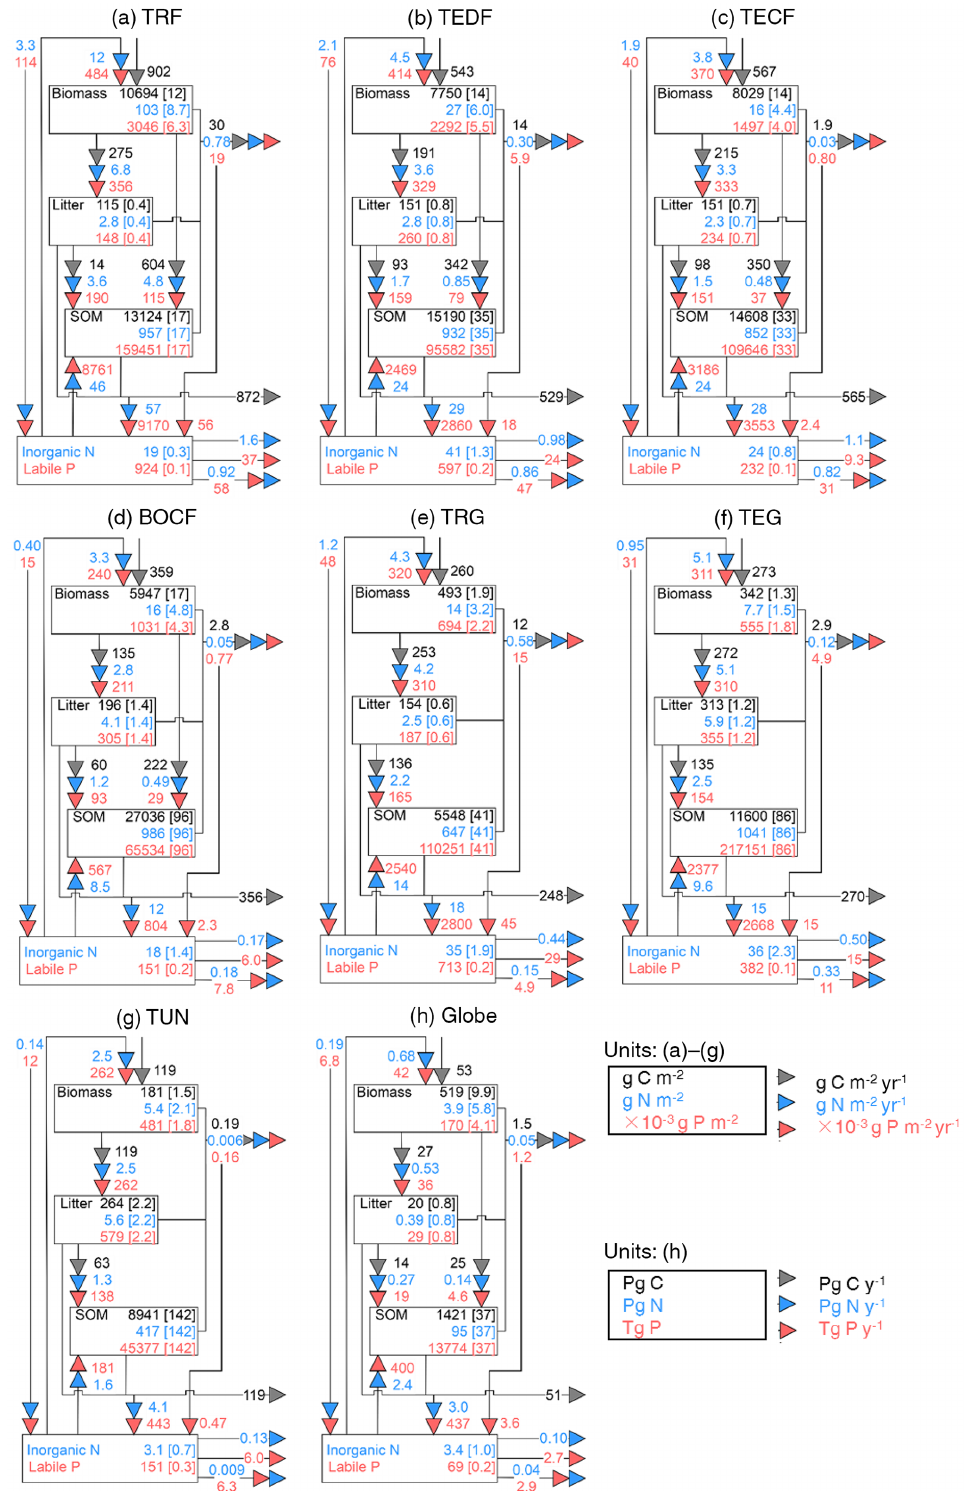
Figure 3. Fluxes (numbers along arrows), mean residence times (in parentheses), and pool sizes of the N (blue) and P (red) cycles in the terrestrial biosphere at steady state for the large biomes (a–g) and the globe (h) . The targeted biomes are tropical rainforests (TRF, a ), temperate deciduous forests (TEDF, b ), temperate coniferous forests (TECF, c ), boreal coniferous forests (BOCF, d ), tropical/C 4 grasslands (TRG, e ), temperate/C 3 grasslands (TEG, f ), and tundra (TUN, g